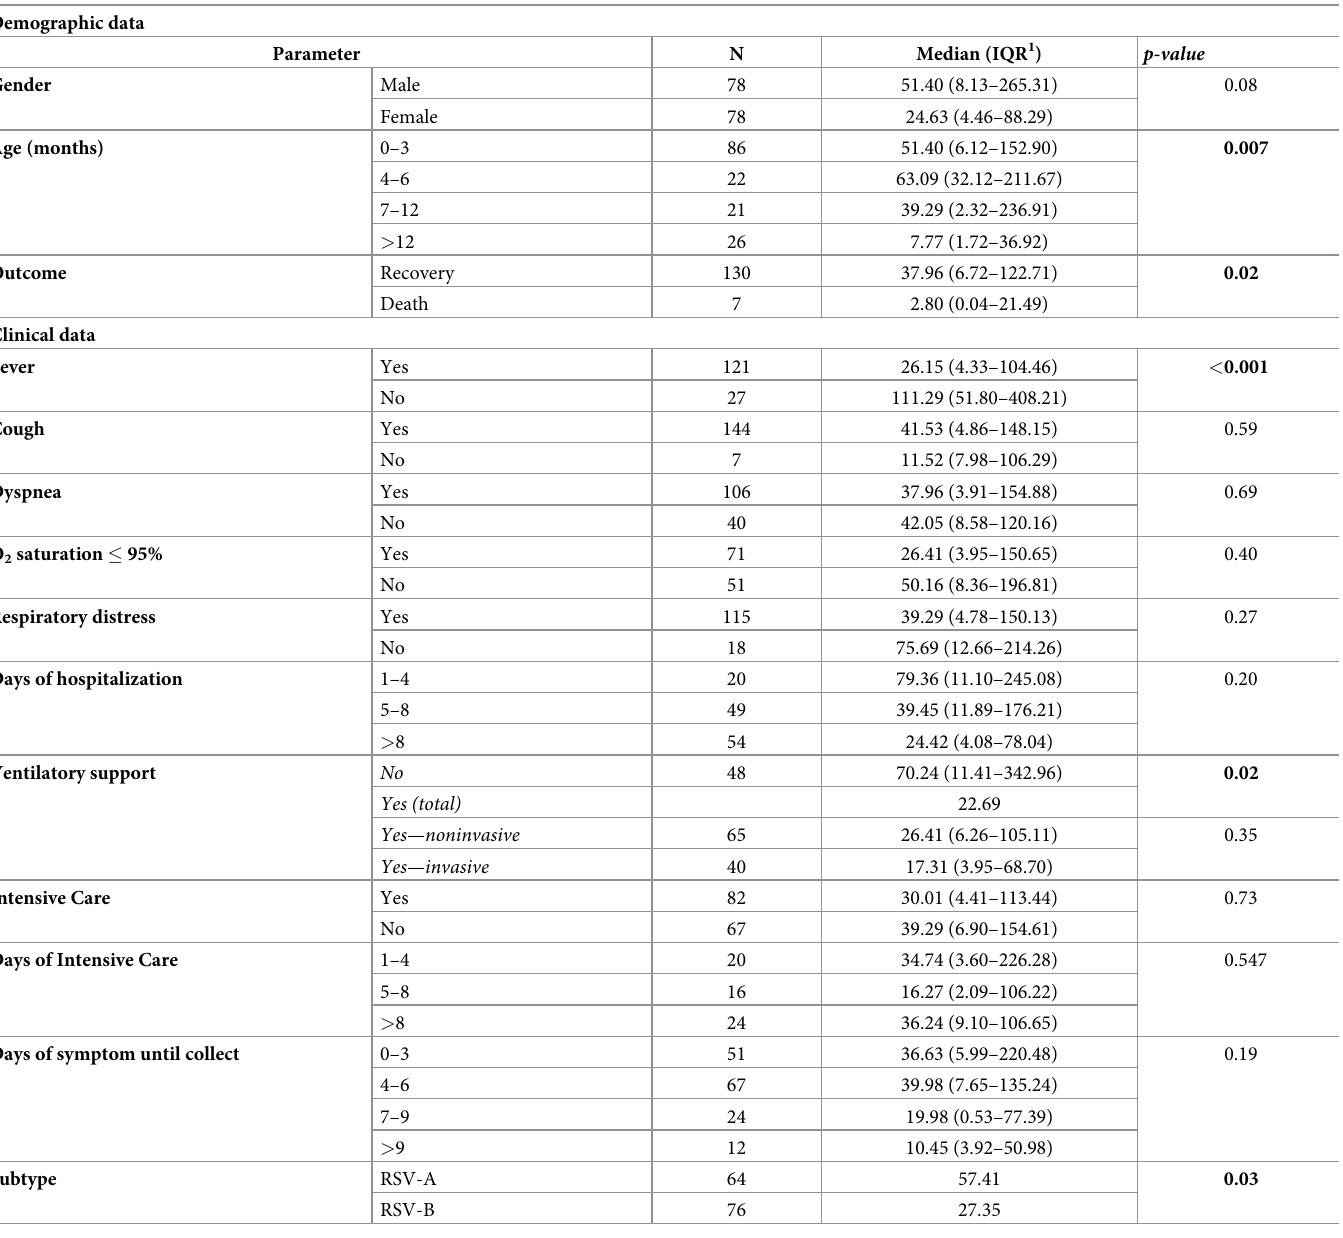
Table 4. Comparison of viral load values between gender, age, outcome, and clinical